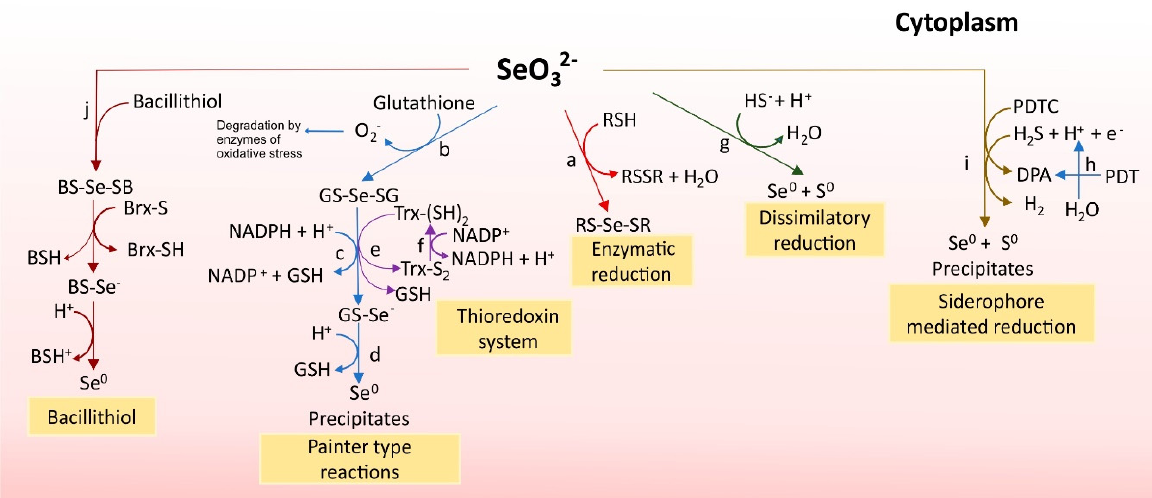
Figure 2. Biochemical pathways for the biological reduction of Se. ( a ) Enzymatic reduction, ( b ) methylation, ( c ) dissimilatory reduction concomitant with sulfate reduction, ( d ) painter-type reactions with the thiols of proteins as well as glutathione, ( e , f ) thioredoxin system, ( g ) dissimilatory reduction, ( h , i ) chemical reaction with the siderophore-iron-specific (Fe 3+ ) and ( j ) pathway analogous to those observed with GSH that involve Brx-like proteins. Image based on Zannoni et al. [120] and Helmann et al. [121].